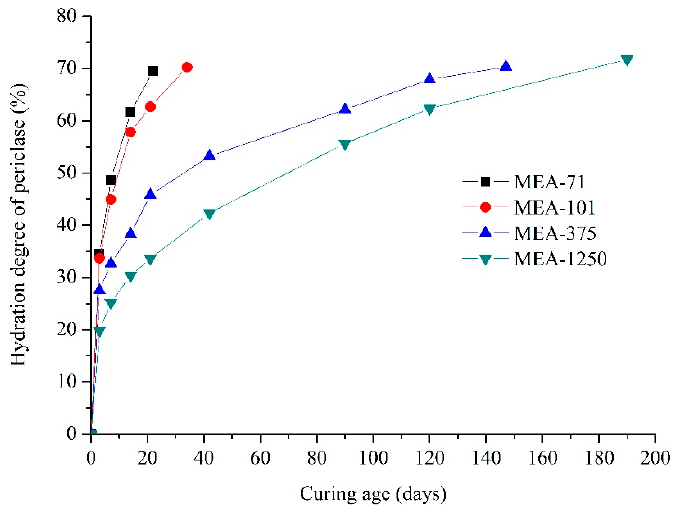
Figure 5. Hydration degree of periclase in compacted MEAs cured in water at 40 °C.